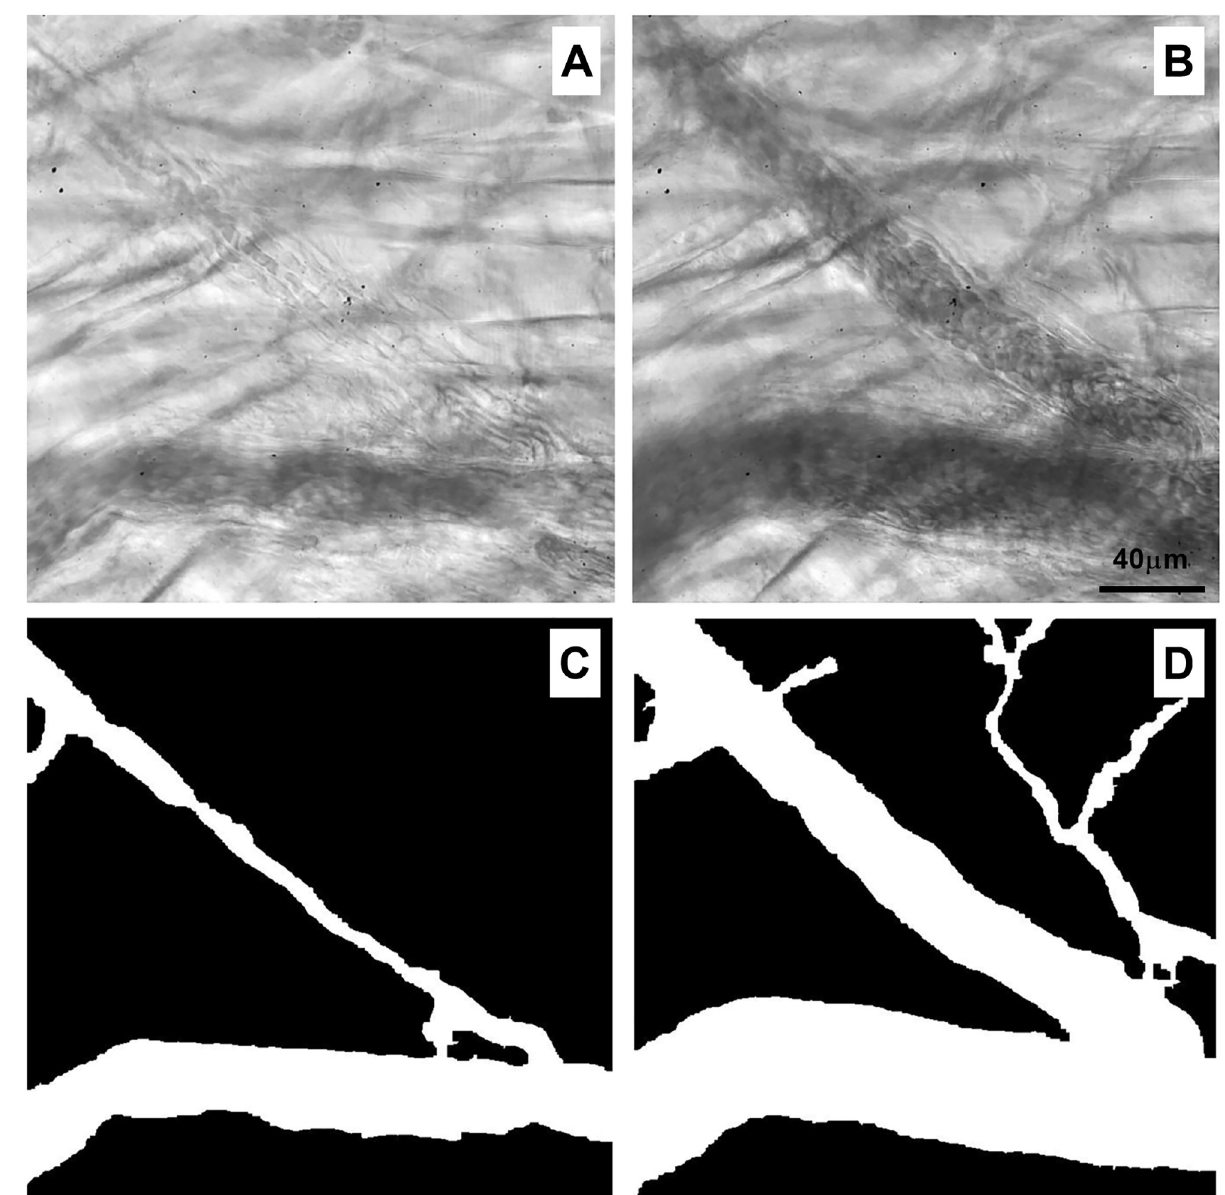
Fig 8. Effect of histamine on microcirculation of mice cremaster muscle. (A) Contracted arteriole elicited by stimulation with histamine (1 mM). (B) Arteriole in basal condition. (C) Processed image of arteriole stimulated with histamine. (D) Processed image of arteriole in basal condition.